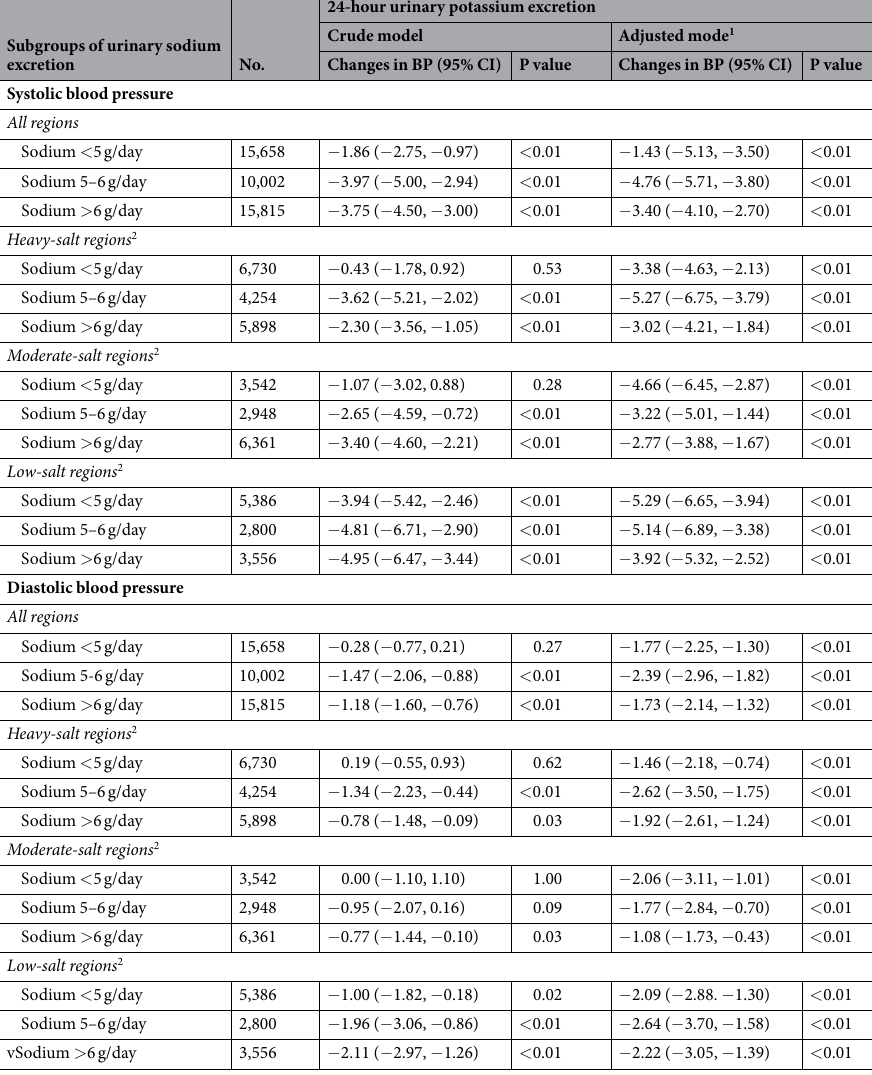
Table 3. Adjusted associations of blood pressure with 24-hour urinary potassium excretion at various levels of urinary sodium excretion. Note: BP, blood pressure (mmHg); CI, confidence interval; 1 Adjusted for age, sex, China centers were classified three salt-diet regions: heavy-salt regions ( > 8 grams of daily salt intake) included Beijing, Jiangsu Province, Jiangxi Province, and Liaoning Province; moderate-salt regions (7 to 8 grams) included Qinghai Province, Shaanxi Province, and Shandong Province; low-salt regions ( < 7 grams) included Inner Mongolia, Sichuan Province, and Yunnan Province, Shanxi Province, and Xinjiang